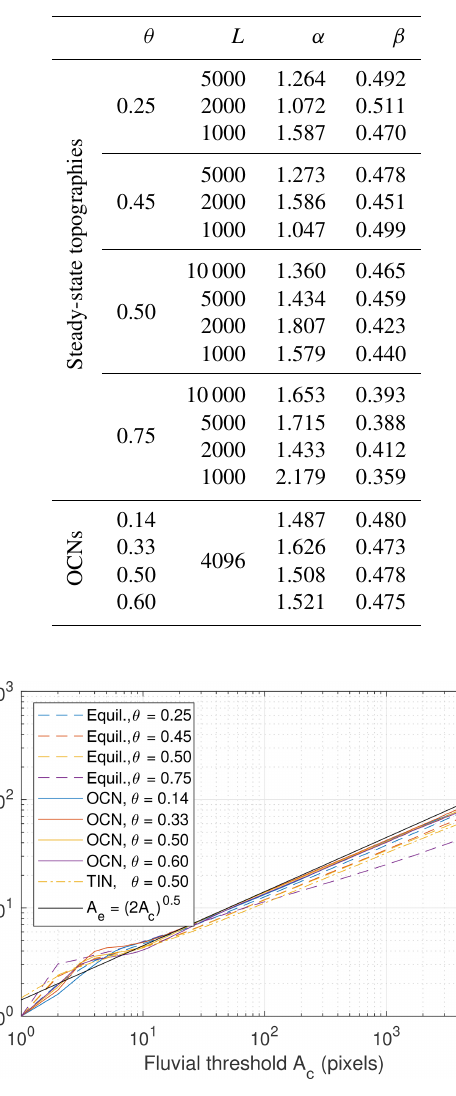
Figure 8. Eroded area A e as a function of the fluvial threshold A c for the considered drainage networks. For clarity, only the results obtained from the largest domains are